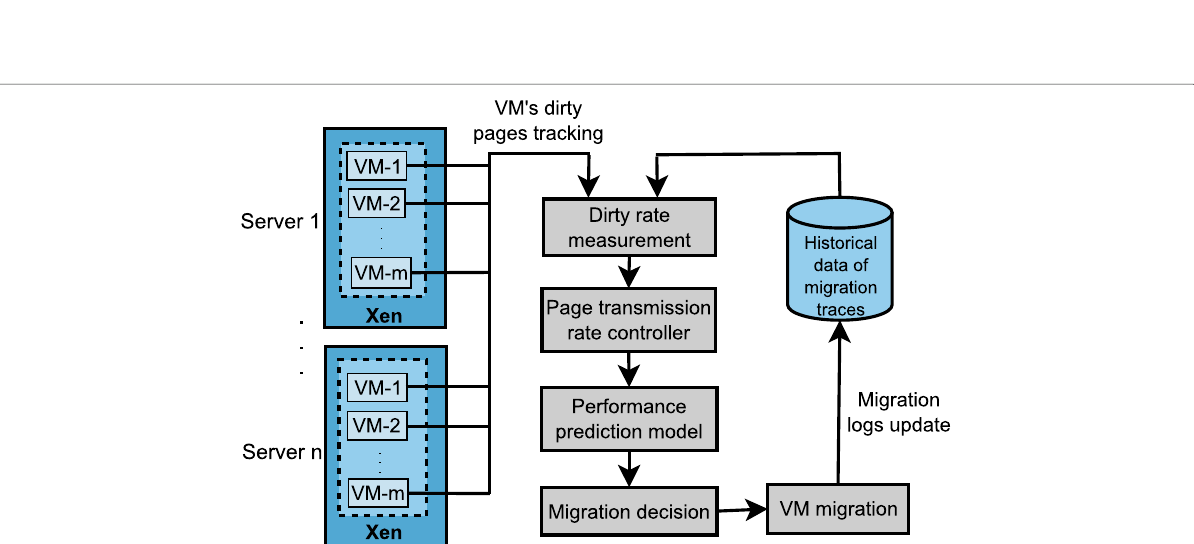
Fig. 5 Generic model of live VM